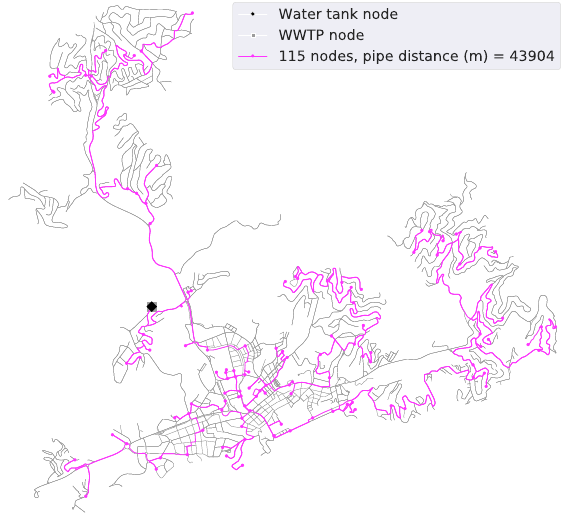
Fig. 2 Reclaimed water network visualization (Lloret de Mar). The diagram on the left shows the resulting reclaimed water network for only public cases, while the one on the right shows the resulting reclaimed water network for both public and private uses. The city street graph is represented in gray paths and the reclaimed water network in magenta paths.